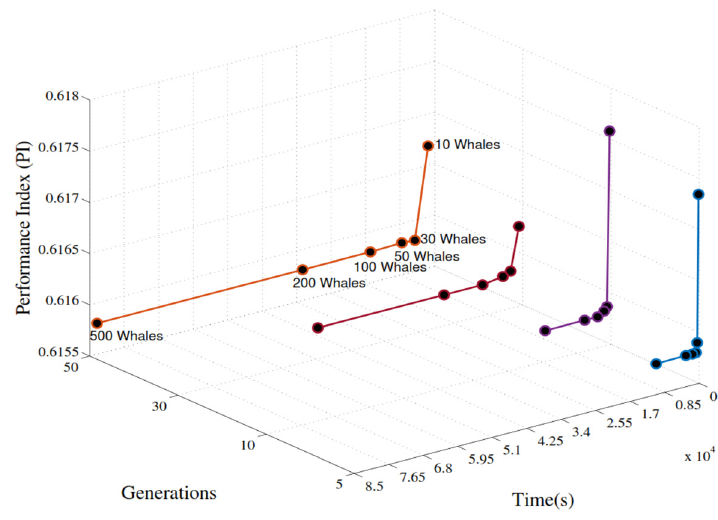
Figure 3. Calibration process of the optimization algorithm.